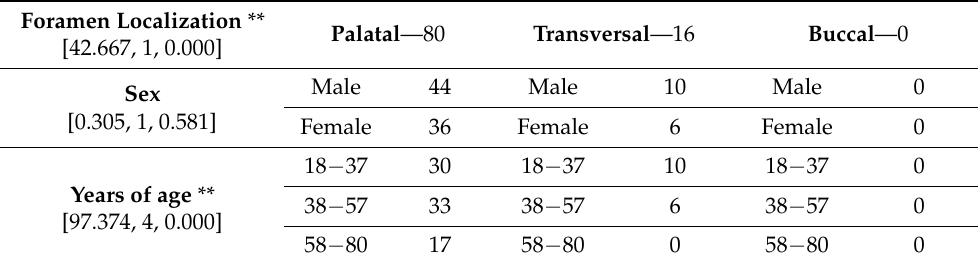
Table 4. Accessory canal foramen